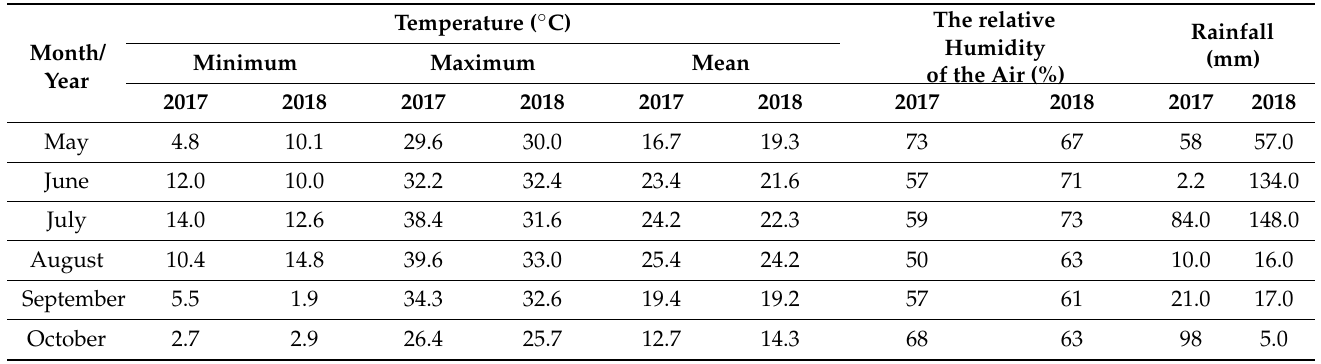
Table 1. The climatic conditions during the vegetation period of the sweet potato